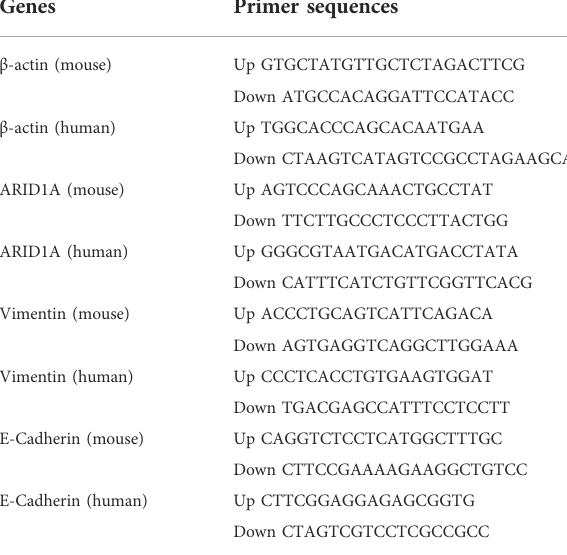
TABLE 2 The RT-PCR primers of interested